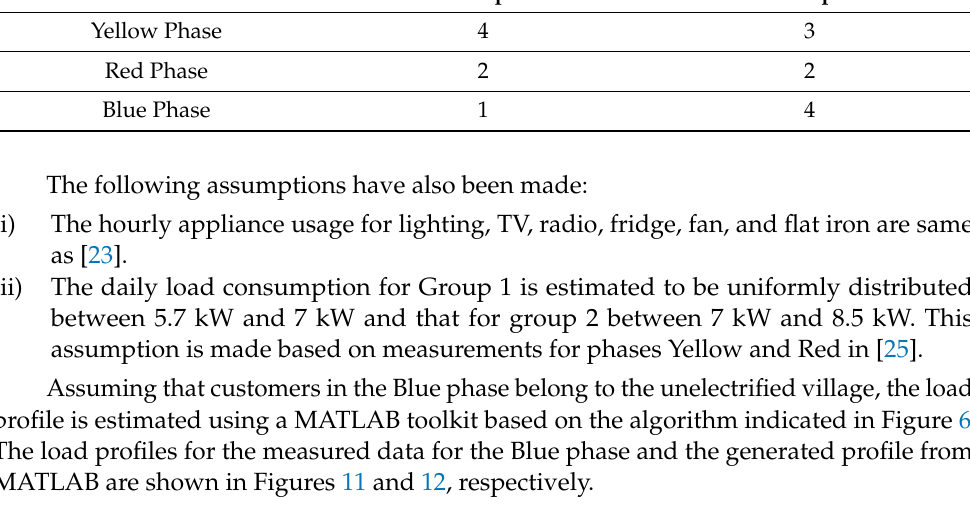
Figure 12. Estimated load profile for new village to be electrified. It can be noted that the profiles are similar apart from the morning peak. The average power consumed per day in [25] using measurements for two days is 32.3kW. This is close to the average power consumed per day of 37.3 kW obtained by summing up the con- sumption for each hour in Figure 12. While there may exist slight differences in the specific household characteristics and domestic appliances used, these results show that data from a proxy village can be used to estimate with minimal error the load in an unelectrified village.